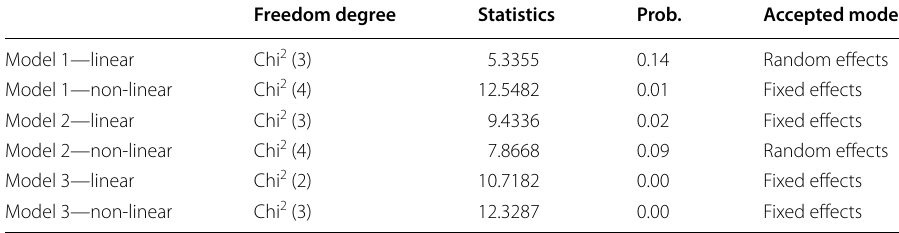
Table 3 Hausman test